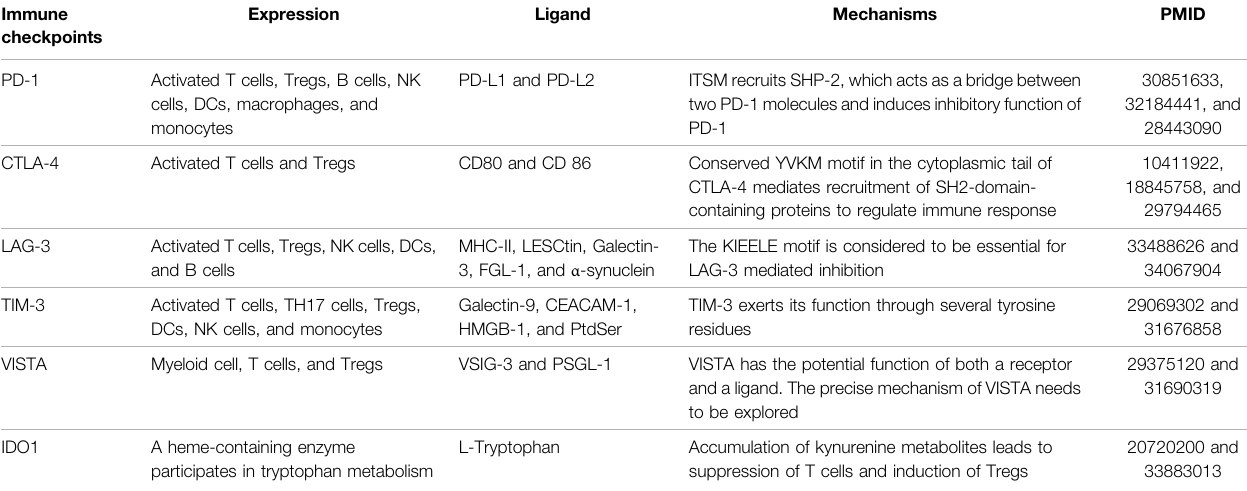
TABLE 1 | The expression and mechanism of the immune checkpoints. Immune